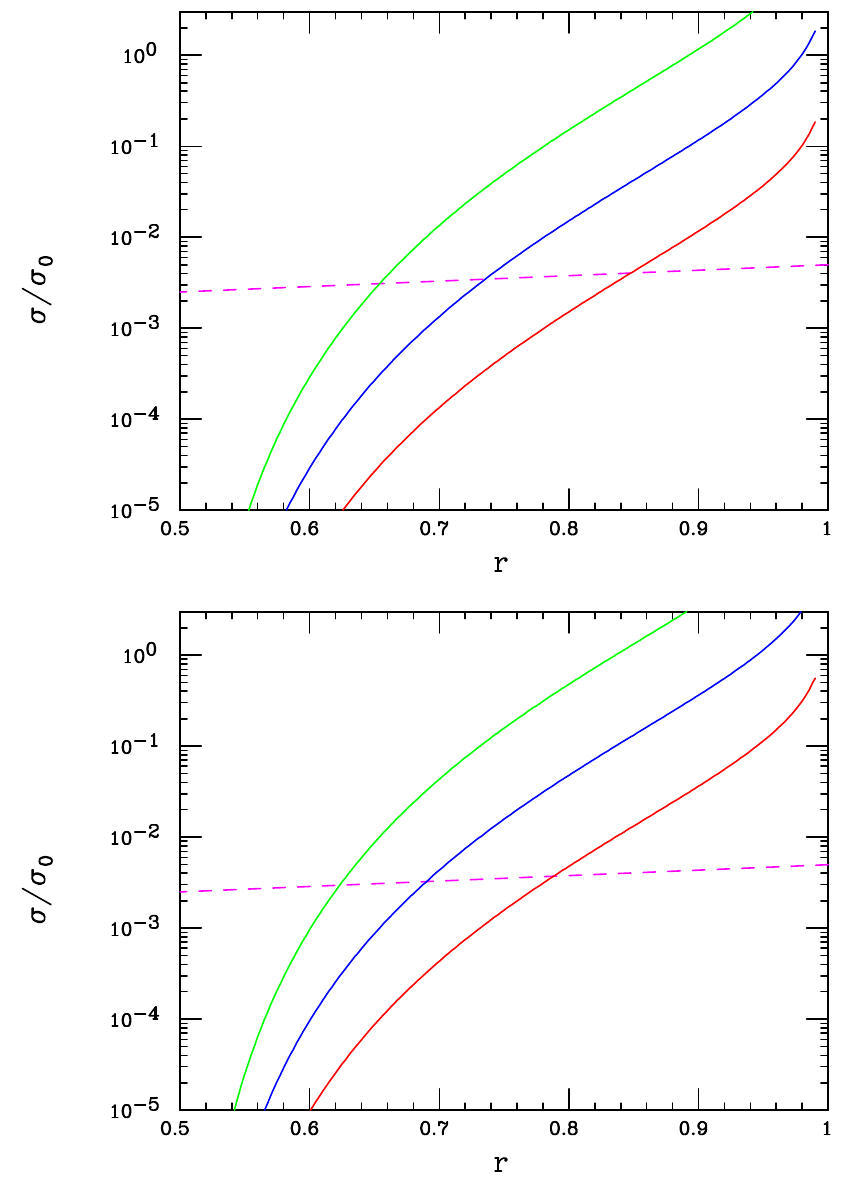
Figure 6 . (Top) s − wave 3-body DP ISR annihilation cross section as a function of r in units of σ 0 assuming δ = 0 . 05 and m V = 100 MeV with, from bottom to top, (cid:15) = 10 − (3 , 3 . 5 , 4) . The approximate upper limit on this cross section arising from the CMB [47] is also shown as the dashed line. (Bottom) Same as the top panel but now with δ = 0 . 1